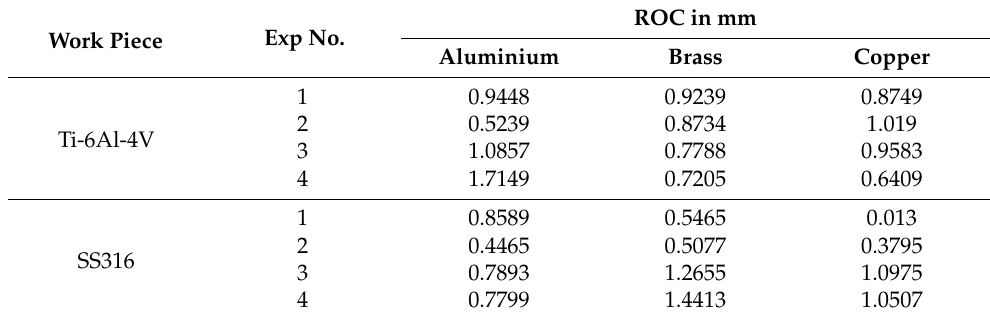
Table 9. The values of ROC for different tool–work piece combinations for different experiments.